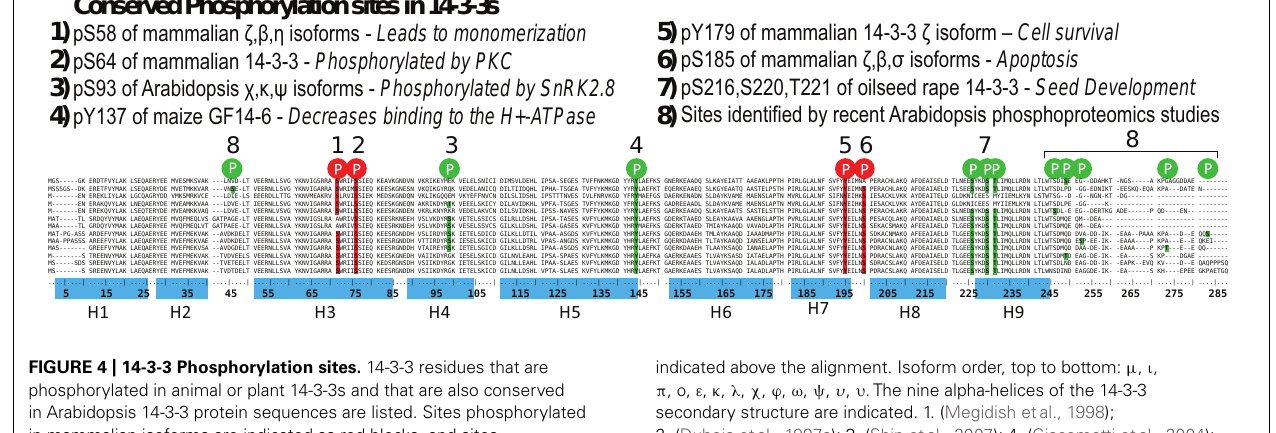
indicated above the alignment. Isoform order, top to bottom: μ , ι , π , o , ε , κ , λ , χ , ϕ , ω , ψ , υ , υ .The nine alpha-helices of the 14-3-3 secondary structure are indicated. 1. (Megidish etal., 1998); 2. (Dubois etal., 1997a); 3. (Shin etal., 2007); 4. (Giacometti etal., 2004); 5. (Barry etal., 2009); 6. (Aitken, 1995;Tsuruta etal., 2004); 7. (Agrawal and Thelen, 2006); 8. (Reiland etal., 2009; Sugiyama etal., 2008; Mayank etal.,